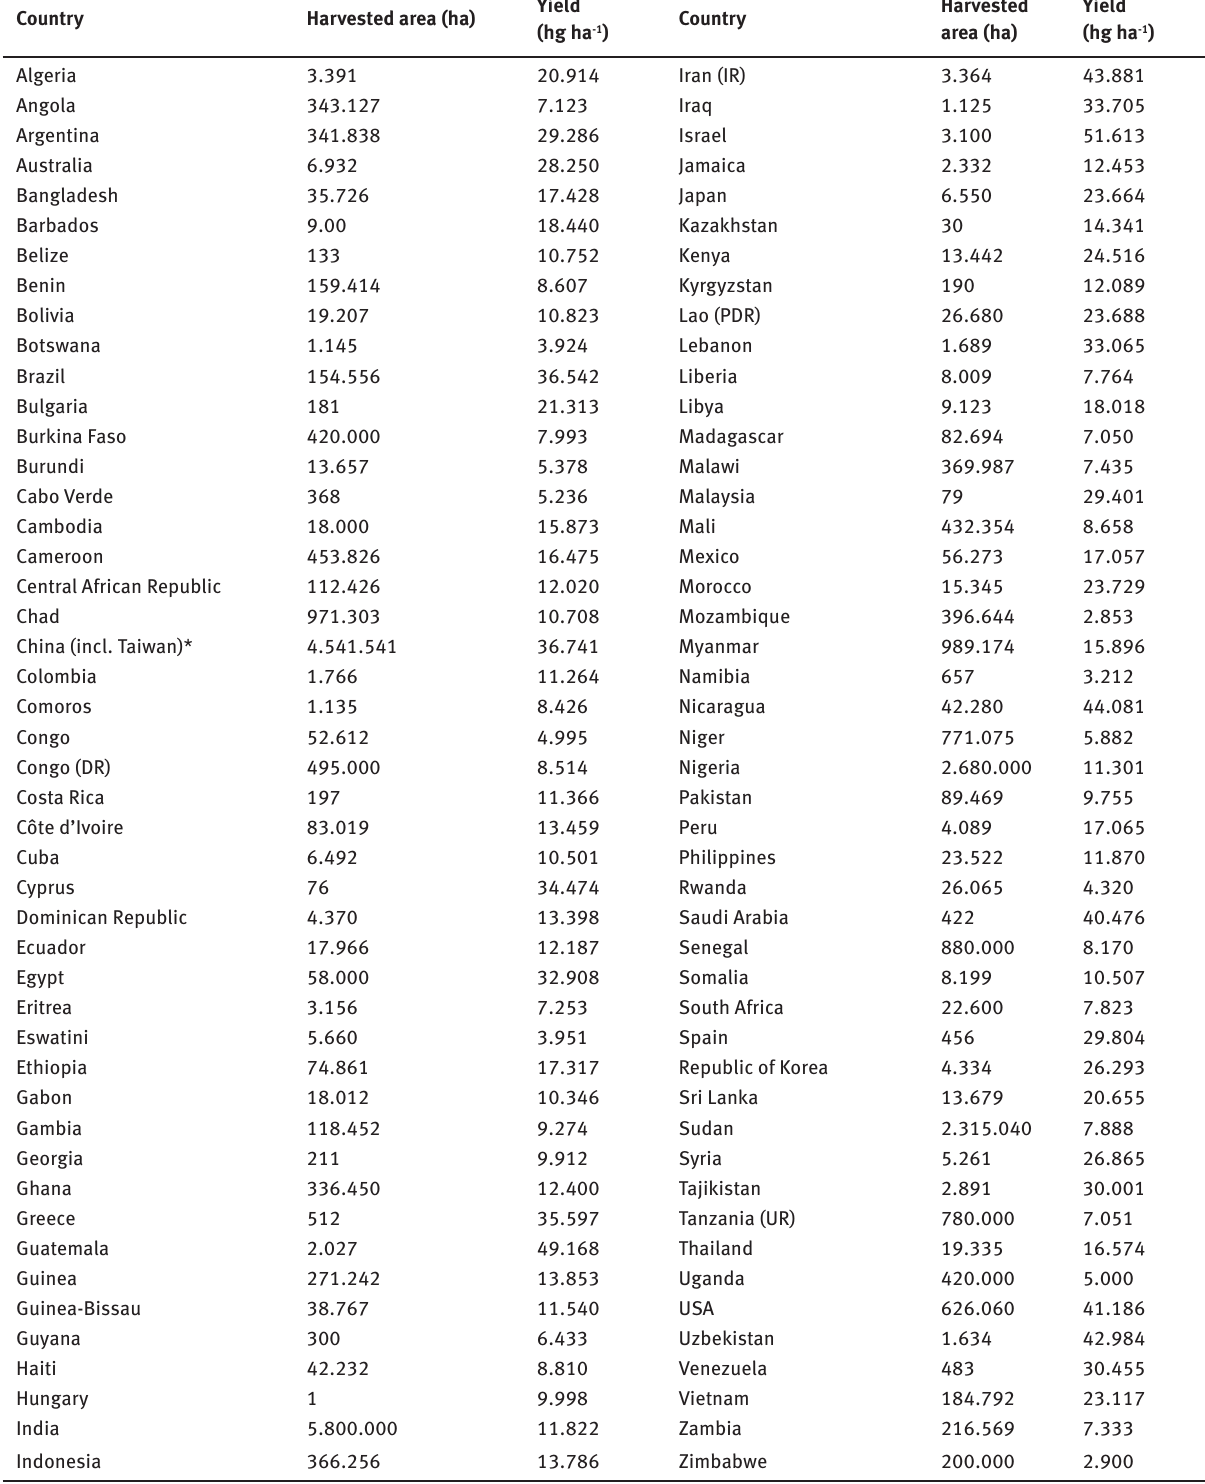
Table 1: Countries around the world that produce groundnut (with shells), listed alphabetically in terms of harvested area and yield, inclu- ding official, calculated and unofficial figures (FAO, 2018). Data presented is the most recent